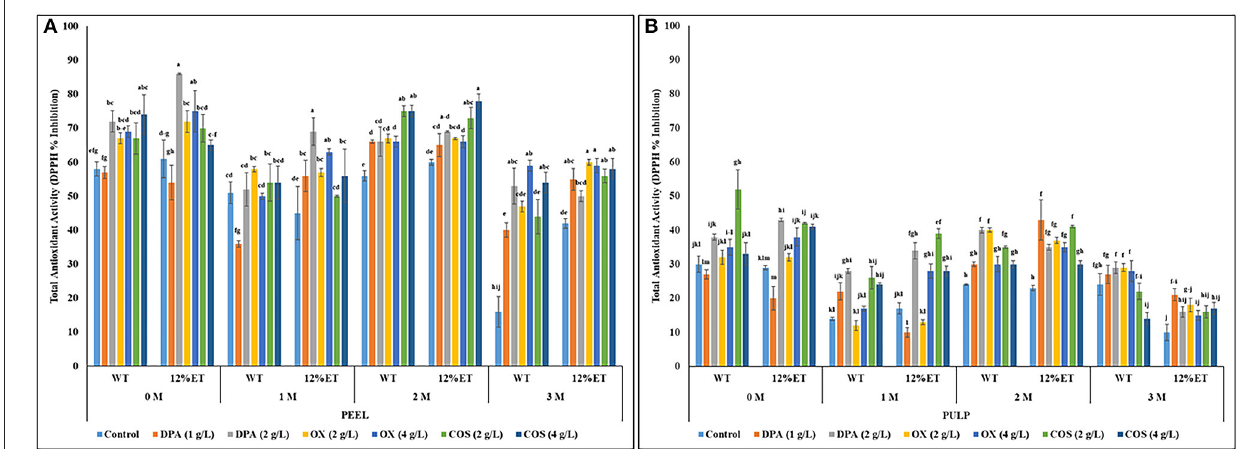
FIGURE 3 | Total antioxidant activity (DPPH-based % inhibition) of aqueous (WT) and ethanol (12%ET) extracts of Cortland apple peel (A) and pulp (B) with elicitor treatments during 3 months of storage. Error bars represent standard errors (S.E.). Different lowercase letters indicate statistically significant ( p ≤ 0.05) differences in total antioxidant activity between sample (peel vs. pulp) × extraction solvent × post-harvest elicitor treatment interactions separately for each storage time